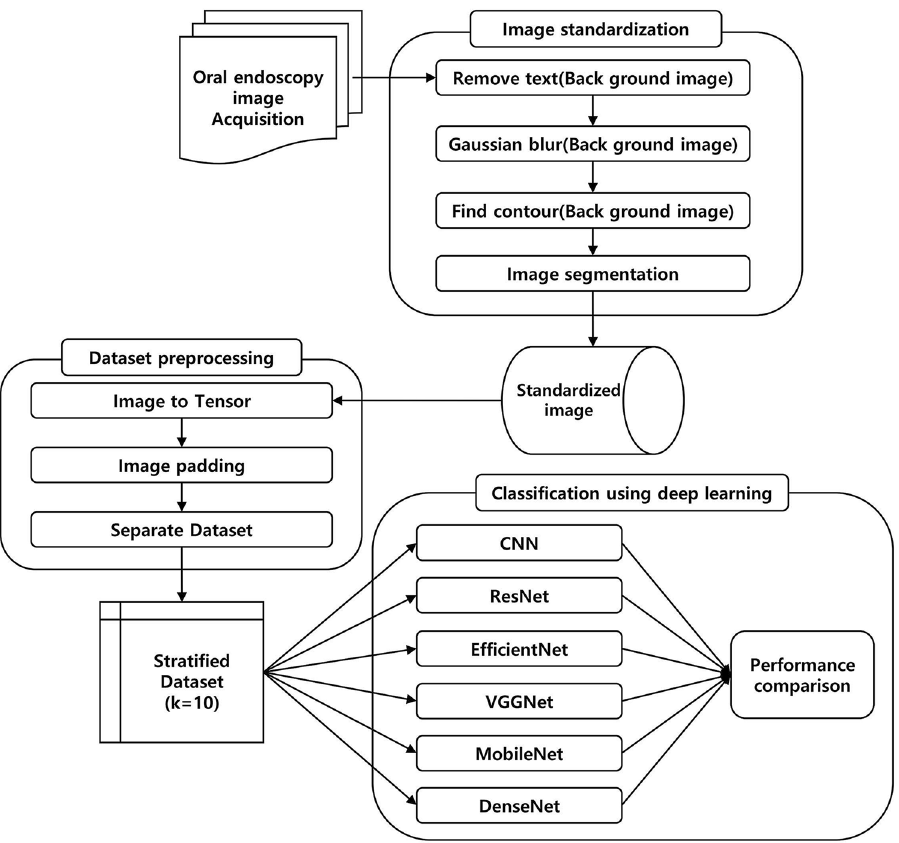
Figure 1. Overview of the development and evaluation of the tongue cancer diagnosis